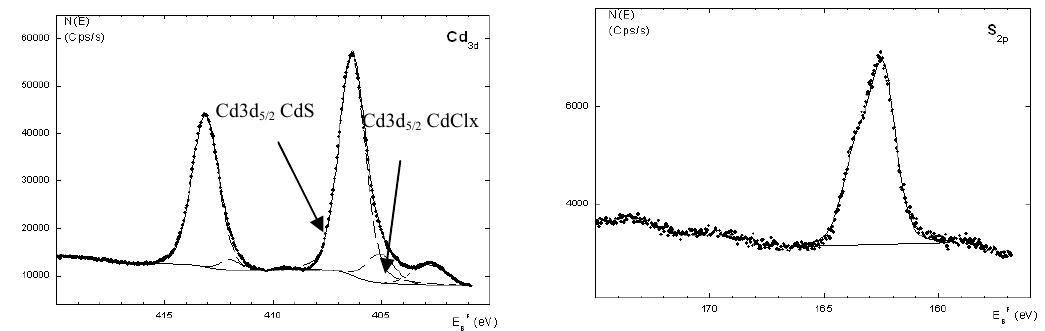
Figure 8. The XPS spectra of CdS: Ia